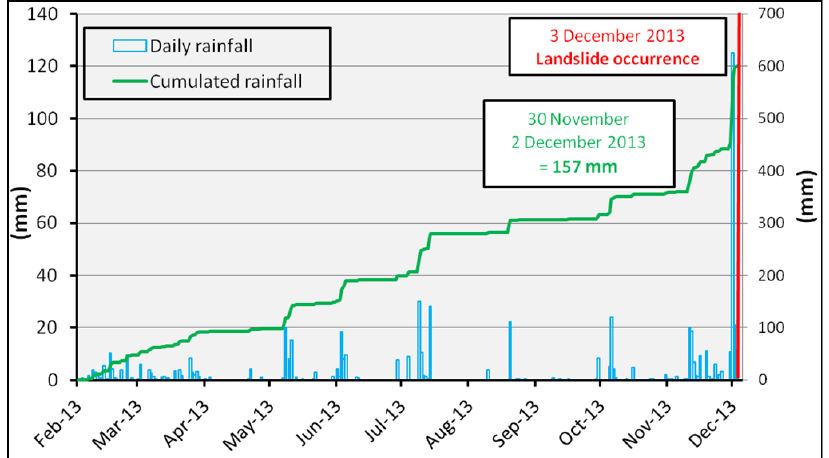
Figure 2. Rainfall recorded before the landslide event at the Matera rain gauge. The red line represents the occurrence of landslide on 3 December